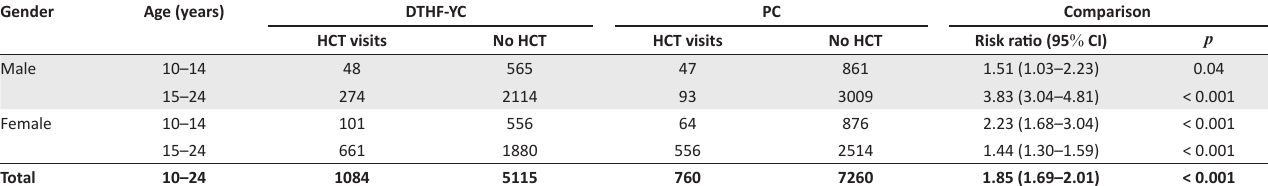
TABLE 2: 2015 Desmond Tutu HIV Foundation Youth Centre versus public clinic HIV testing. Gender